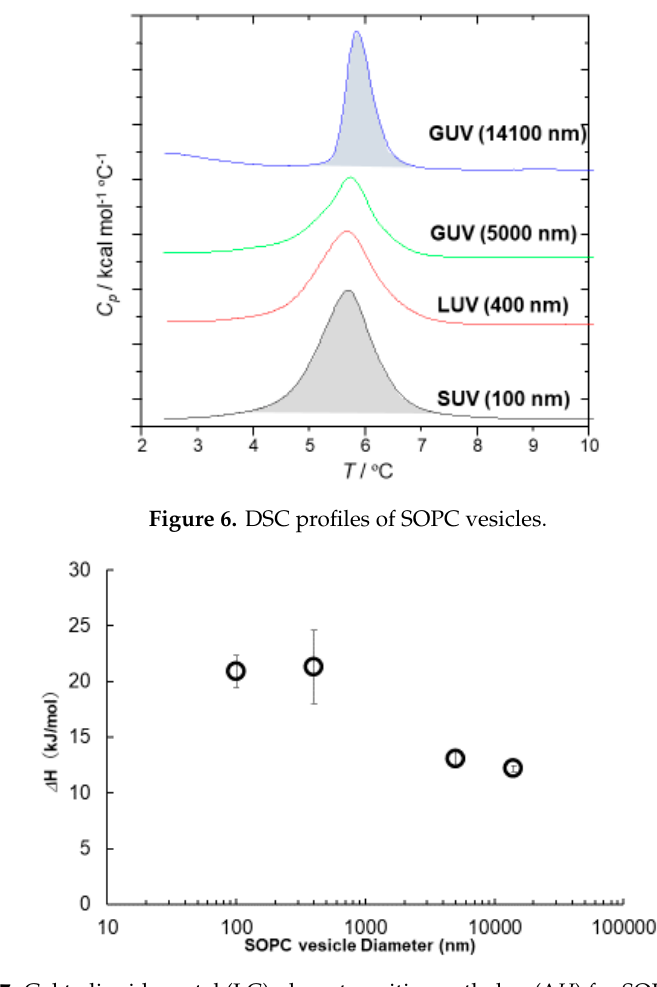
Figure 7. Gel to liquid crystal (LC) phase transition enthalpy ( Δ H) for SOPC vesicles.